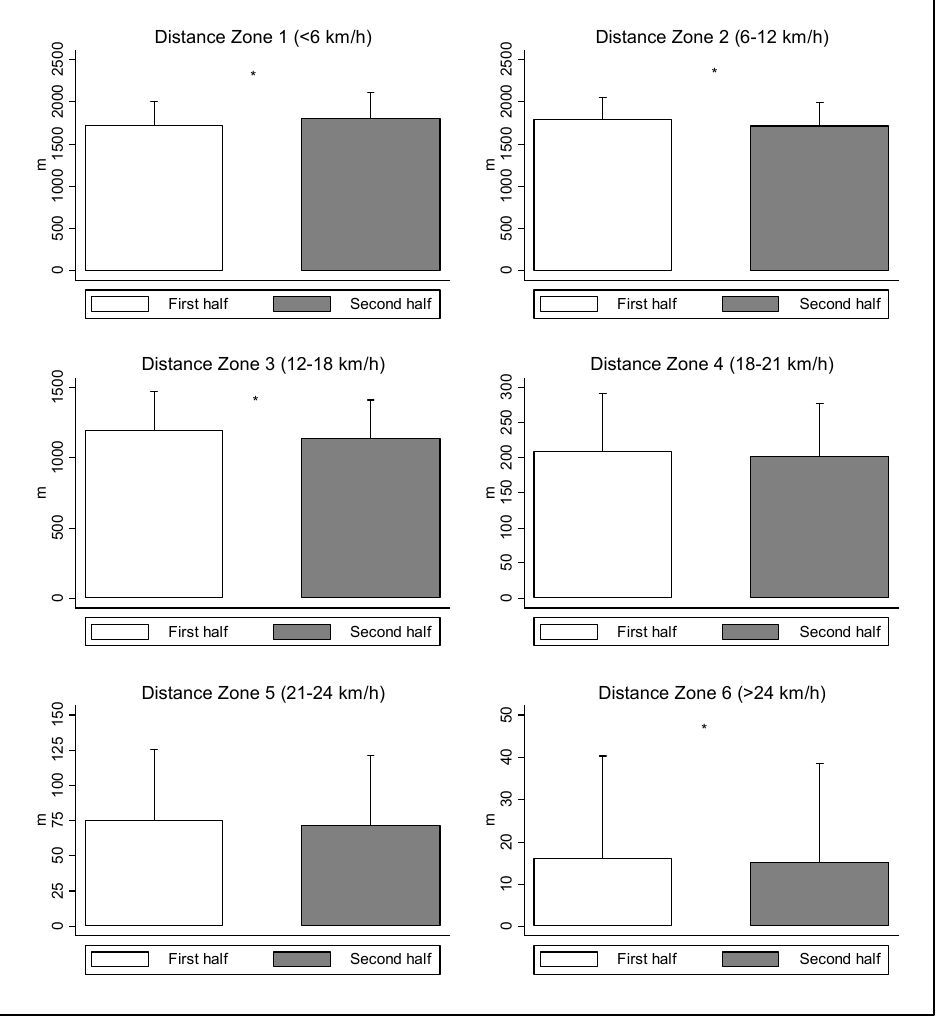
Figure 2. Distance covered in elite football matches by female field referees in different speed zones. * Significant differences between first and second half ( p < 0.05).